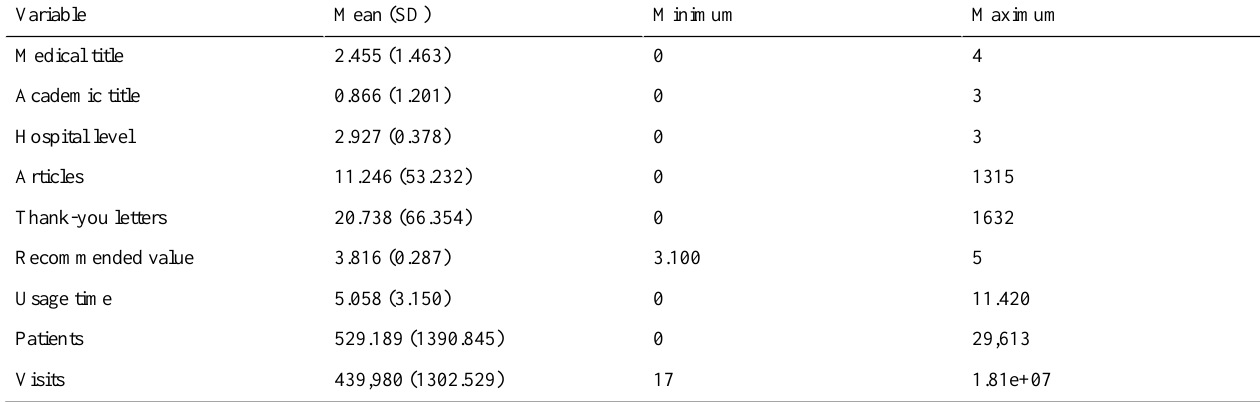
Table 2. Descriptive statistics